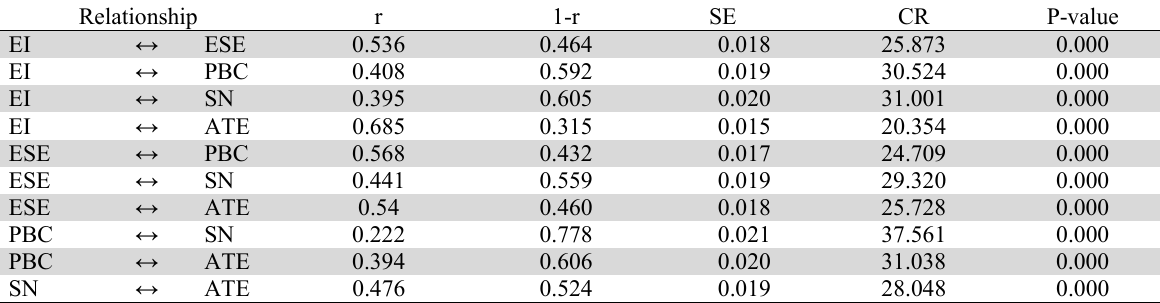
The results of testing the discriminant validity between variables